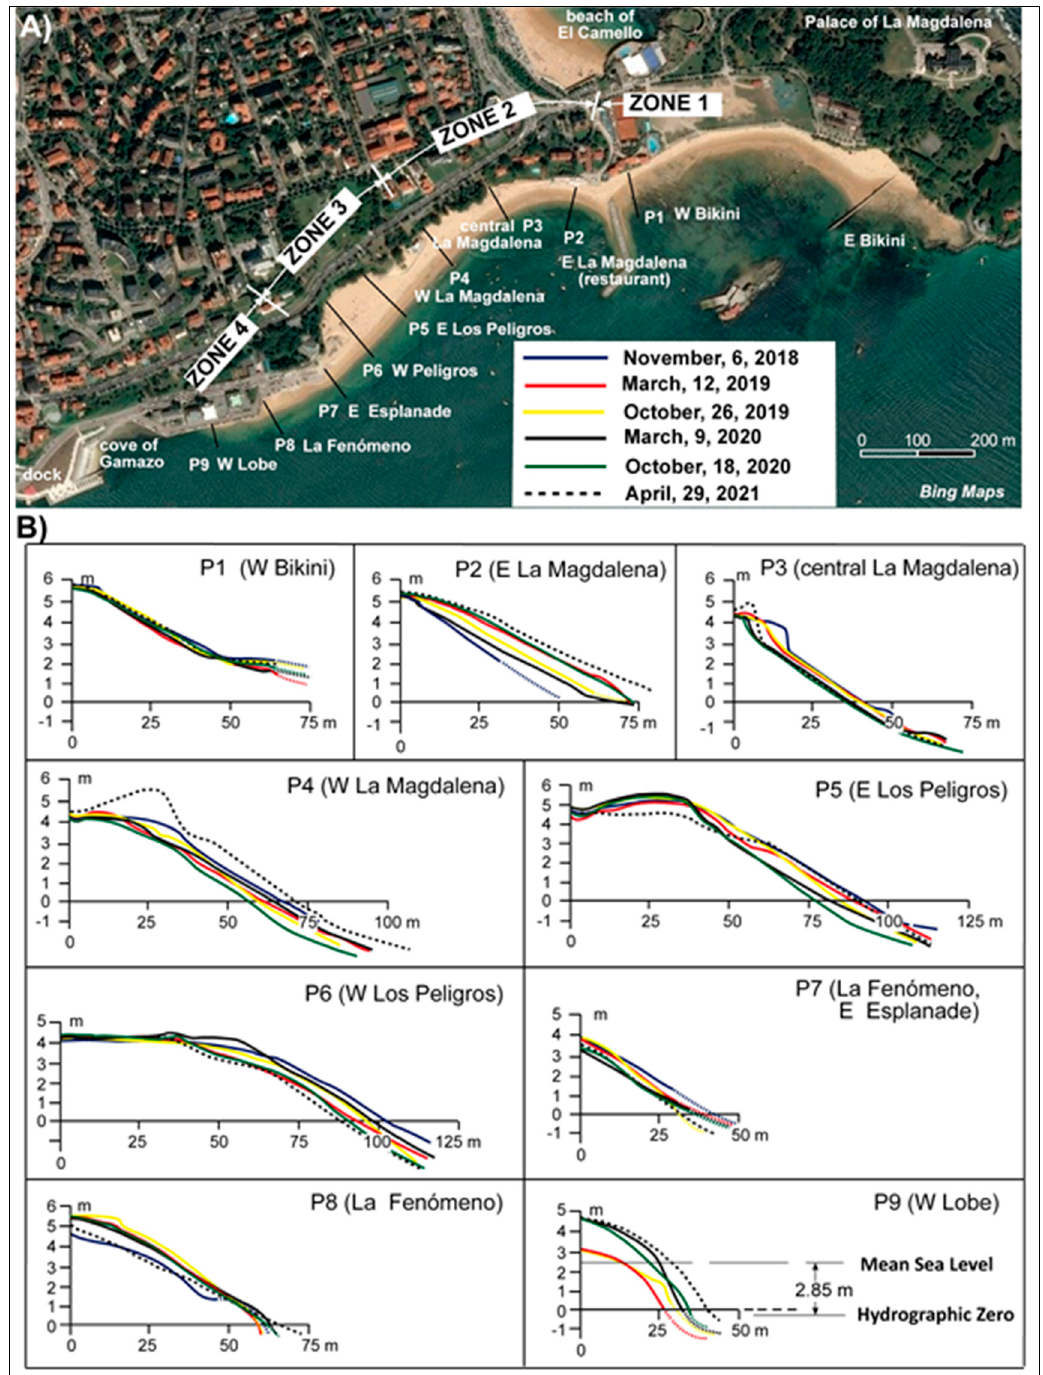
Figure 6. ( A ) Situation of the nine transverse beach profiles (P1-P9) from 2018 to 2021. ( B ) Overlapping profiles from western Bikini (P1) to the lobe (P9) of La Fenómeno to obtain the first picture of the temporal evolution.